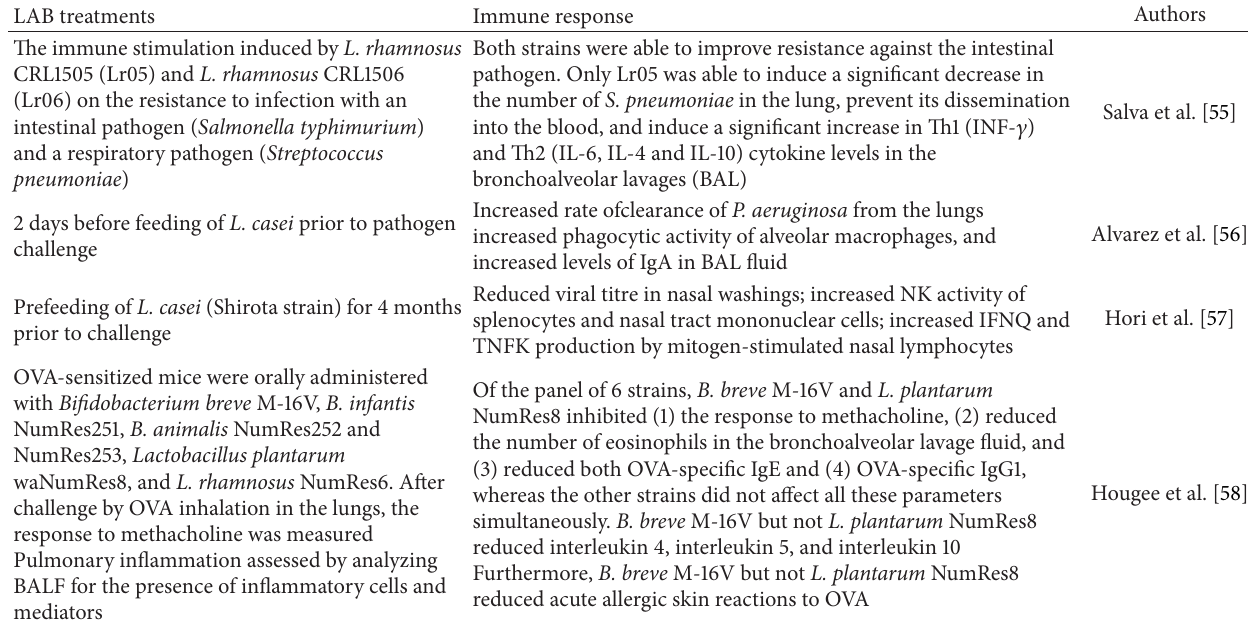
Table 1: Dietary supplementation with lactobacilli that have shown enhanced immune response and protection against respiratory tract pathogen